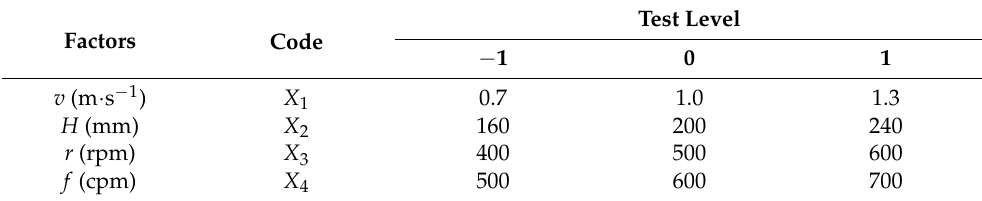
Table 2. Factors and levels of the response surface